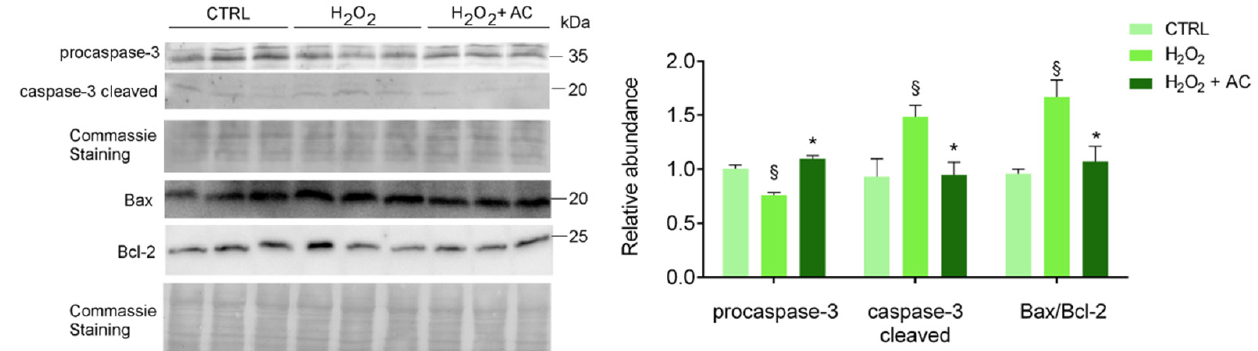
Figure 6. AC reverted the activation of H 2 O 2 -induced apoptotic proteins: WB analysis of rat brain slice lysates maintained in ACSF (CTRL), treated with H 2 O 2 , or with H 2 O 2 in the presence of 200 µ g/mL AC (H 2 O 2 + AC). Antibodies to procaspase-3 (inactive isoform), caspase-3 cleaved (active isoform); the pro-apoptotic factor Bax and the anti-apoptotic factor Bcl-2 were used. The left panel depicts a representative WB along with the Coomassie blue staining of the membrane. Here and after, molecular mass standards (kDa) are reported on the right of each WB image. The right bar graph reports the densitometric analysis for the expression of proteins in the different samples (previously normalized to the optical density of the corresponding Coomassie-stained lane). Data are presented as mean ± SEMs. § p < 0.05 vs. CTRL, * p < 0.05 vs. H 2 O 2 (ANOVA followed by Holm Sidak’s multiple comparison test).